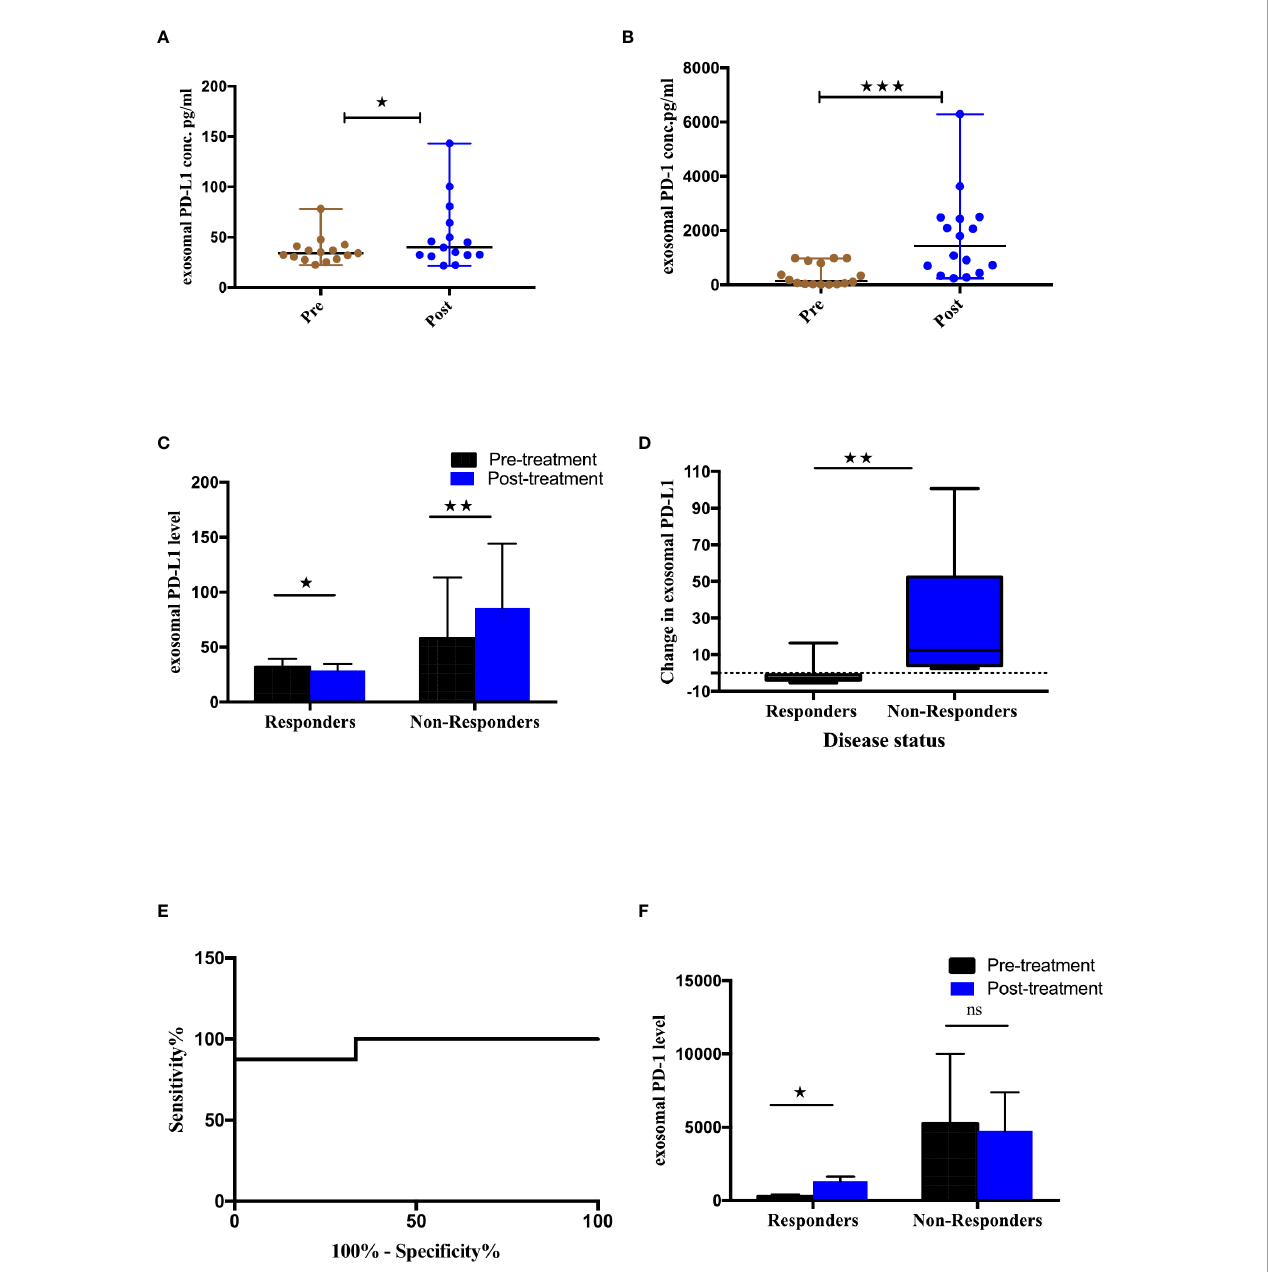
FIGURE 3 Association of exosomal PD-L1/PD-1 levels and clinical outcome. (A, B) Expression of exosomal PD-L1 and PD-1 levels pre and post ICI therapy respectively. (C) Comparison of exoPD-L1 expression in NSCLC patients before and after treatment grouped according to disease status. Two-tailed Wilcoxon matched-pairs signed rank test (*p=0.0156, **p=0.0078) (D) Fold change of exoPD-L1 in responders and non-responders 4-6 months after treatment commencement, to baseline. Mann Whitney(**p=0.0026) (E) Changes in exoPD-L1 levels analyzed using a ROC curve in responders relative to non-responders (AUC = 0.958, CI 95% = 0.865-1.051, SE = 0.047, p = 0.0015). (F) Comparison of exoPD-1 expression in NSCLC patients before and after treatment, grouped according to disease status. Two-tailed Wilcoxon matched-pairs signed rank test (*p=0.0156). **** Highly signi fi cant; ns non-signi fi